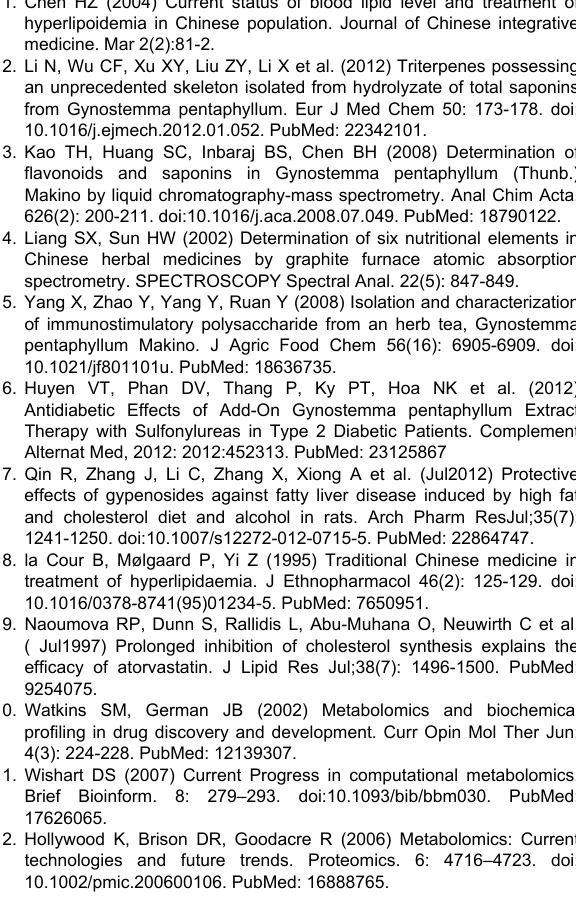
Table S2. Relative integrals from all metabolites except biomarkers in the plasma of rats.